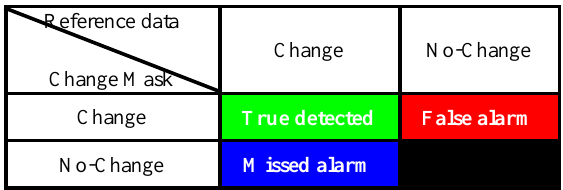
Table 1. The four colors in the overlaid change